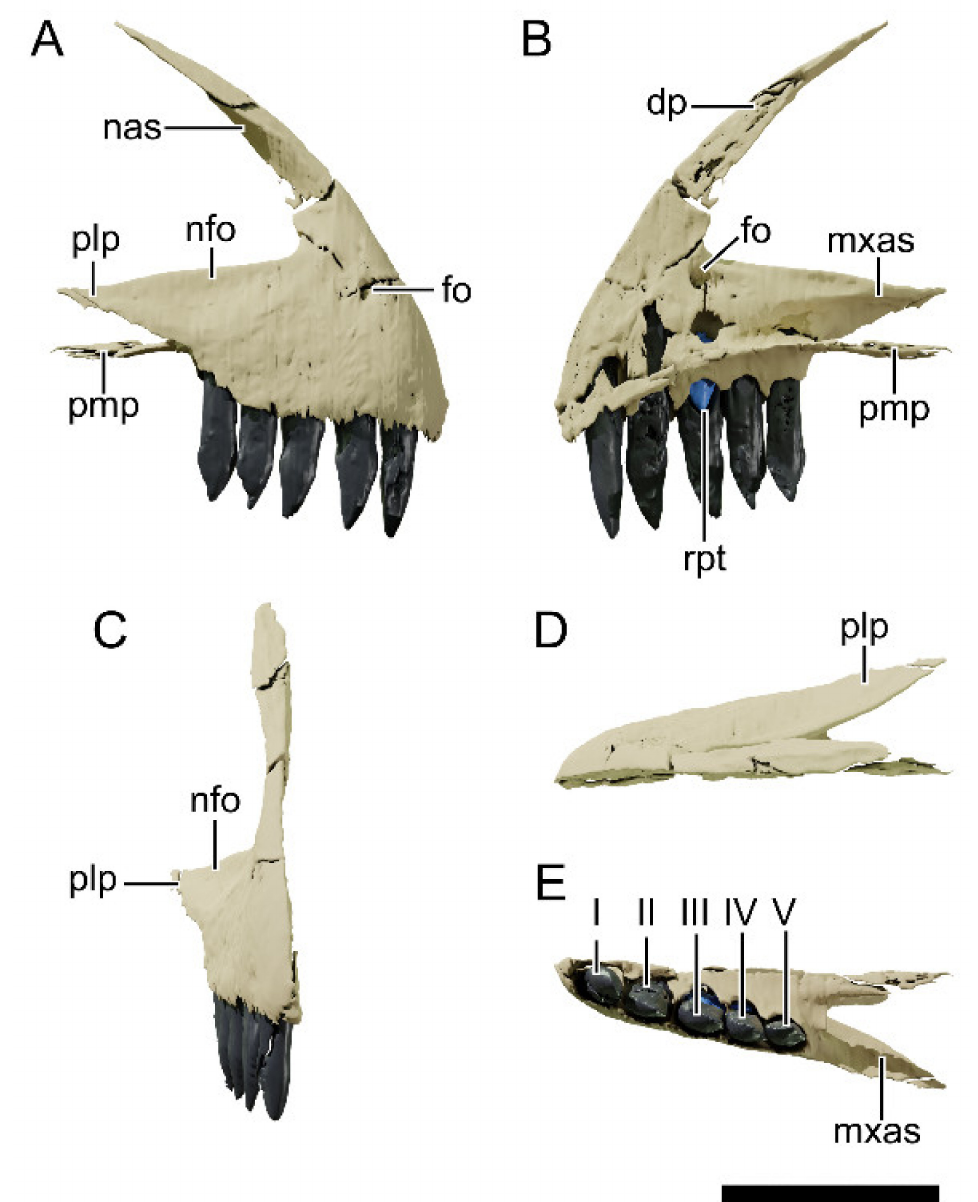
Figure 9. Digital reconstruction of the right premaxilla of NHMD 164758. ( A ) Lateral view. ( B ) Medial view. ( C ) Anterior view. ( D ) Dorsal view. ( E ) Ventral view. Abbreviations: dp, dorsal process; fo, foramen; mxas, articular surface for the maxilla; nas, articular surface for the nasal; nfo, narial fossa; plp, posterolateral process; pmp, posteromedial process; rpt, replacement tooth. I to V represent the tooth position. Scale bar = 20